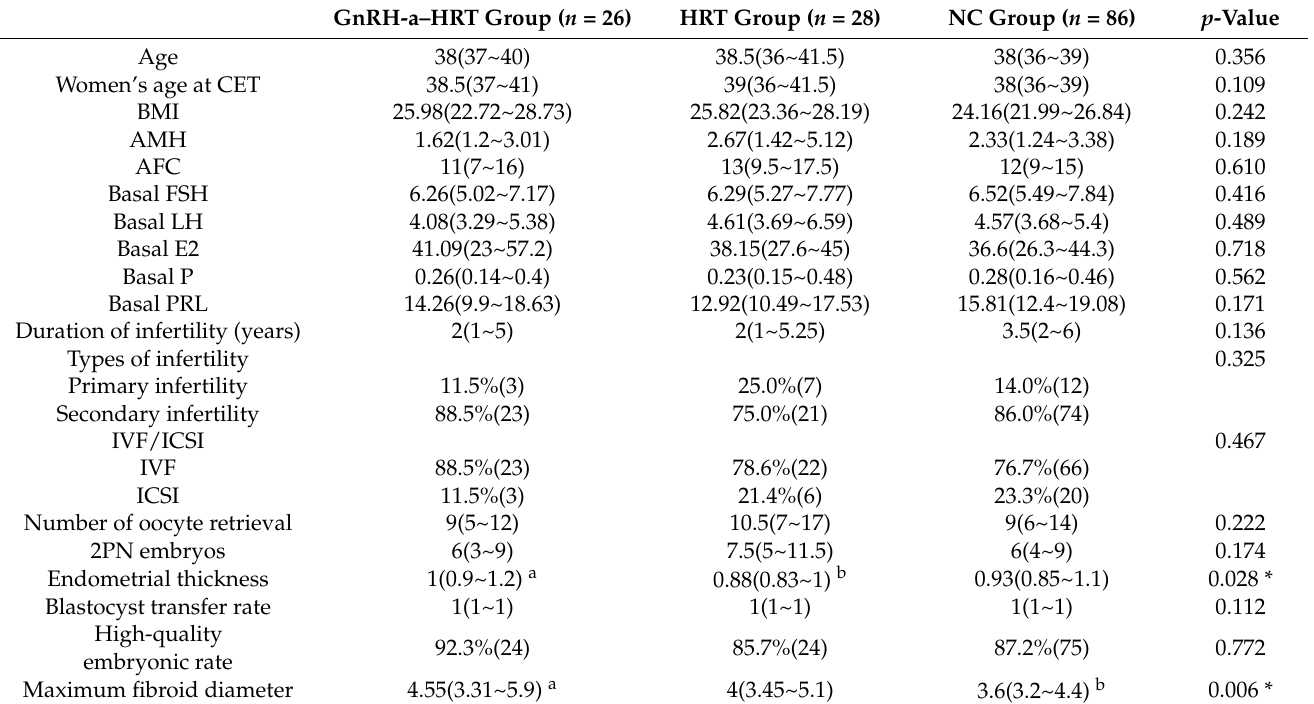
Table 4. Demographic, characteristics and reproductive outcome of patients with fibroids ≥ 3.0 cm among the three